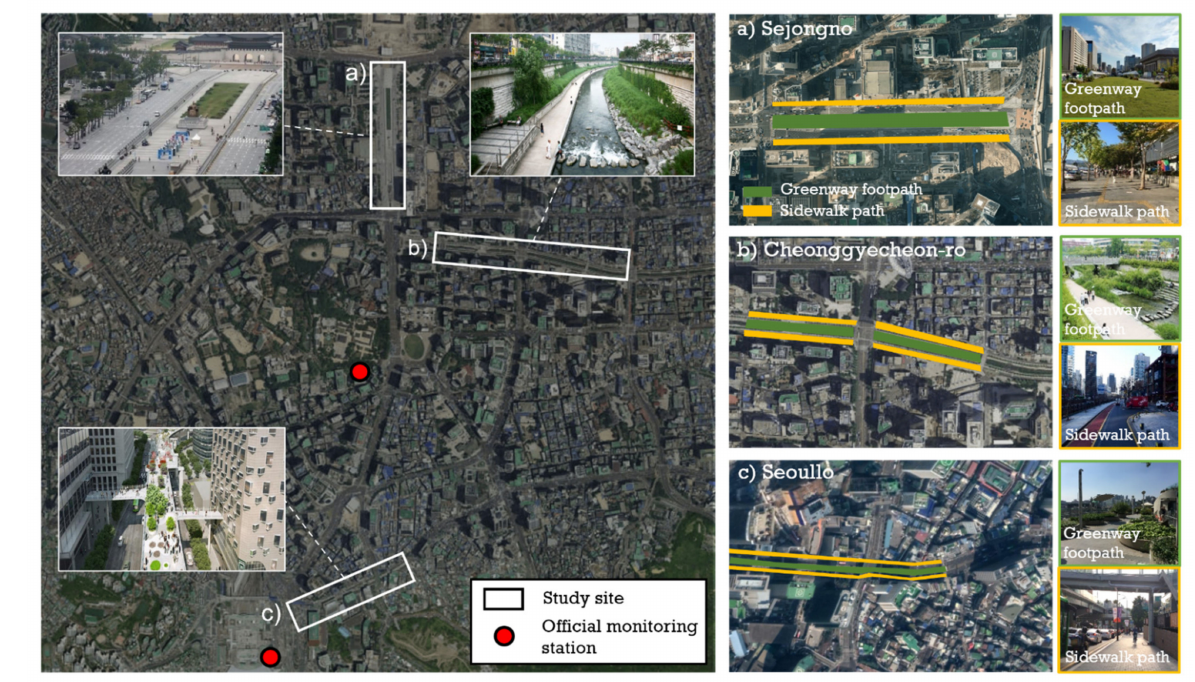
Figure 1. Map of study area.